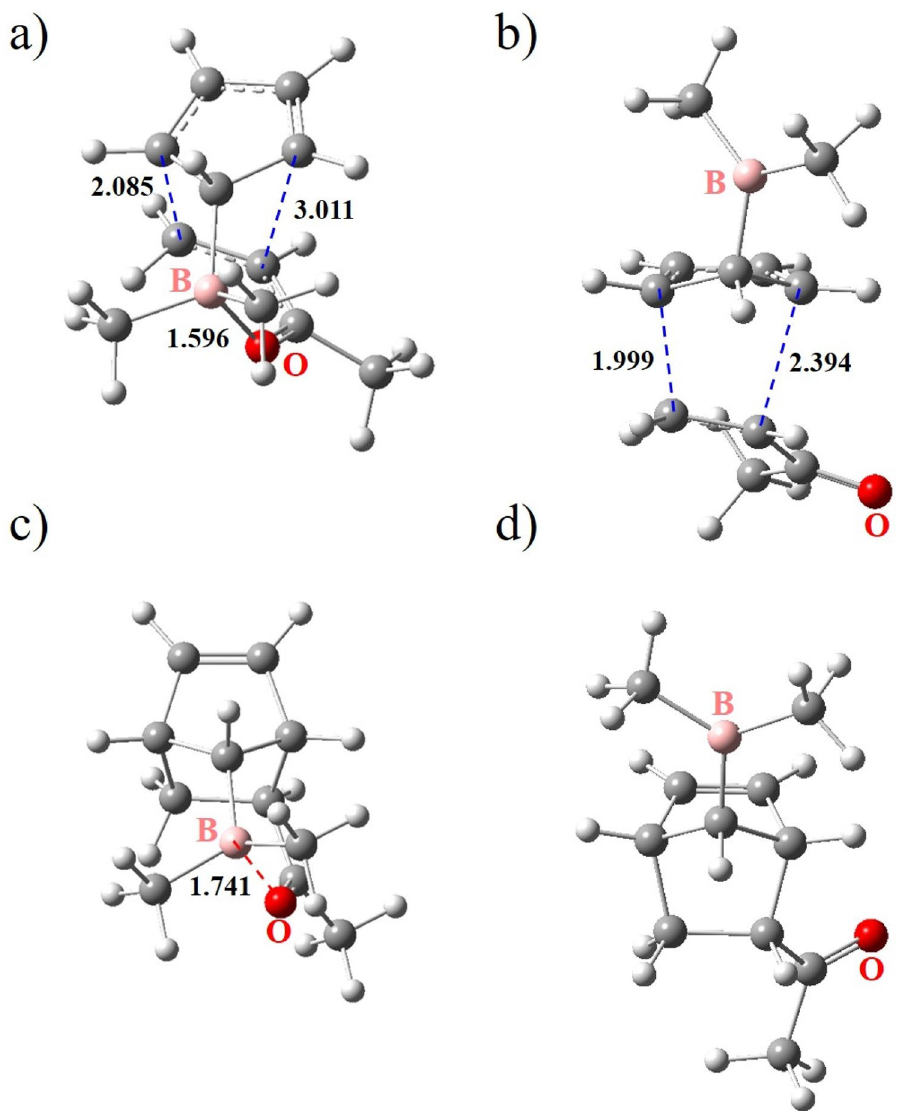
Figure 6. The optimized structures of the exo and endo TSs ( a and b ) and the corresponding final products ( c and d ) obtained for entry 2-2. The blue and red dashed lines represent the newly forming C–C bonds and the LAB interaction, respectively. The numbers indicate the adjacent bond length or atom–atom distance in